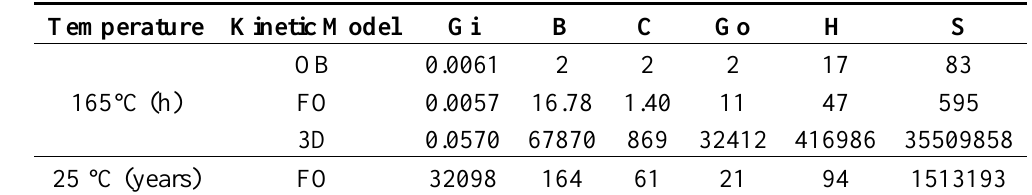
Table 7. Reaction half lives ( t 1/2 ) as calculated by interpolation of Sharp-Hancock lines of best fit to observed data (OB) and the Avrami-Erofe’ev equation predicted for first-order surface control (FO) and 3D diffusion control (3D) for mineral transformations in bauxite residue. Mineral names are abbreviated as follows: Gi—gibbsite; B—boehmite;